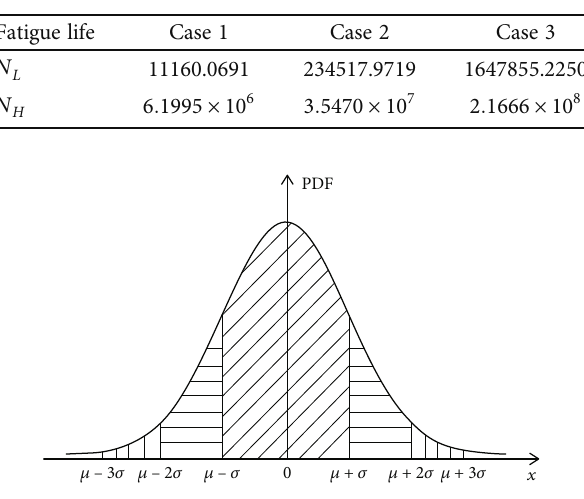
Table 4: Calculation results of turbine blade life.